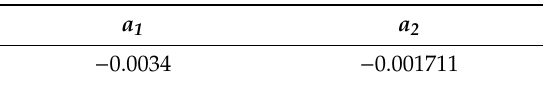
Table 4. Parameters of the linear model.